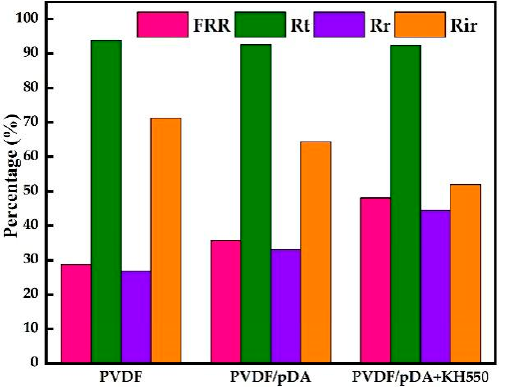
Figure 7. Comparison of fouling index under pectin solution UF test.